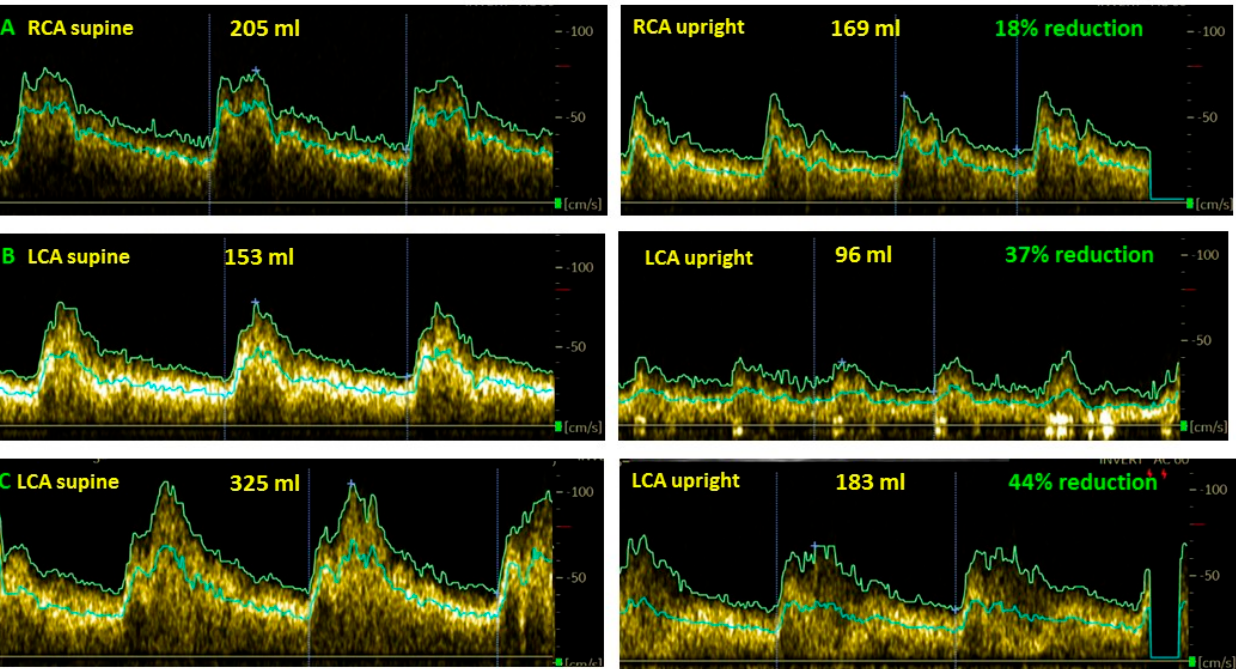
Figure 4. Examples of cerebral blood flow decrease while upright compared to supine in ME/CFS patients with a trigger of EBV. ( A ): female, 38 years; ( B ): female, 21 years old; ( C ): female, 23 years LCA: left carotid artery.